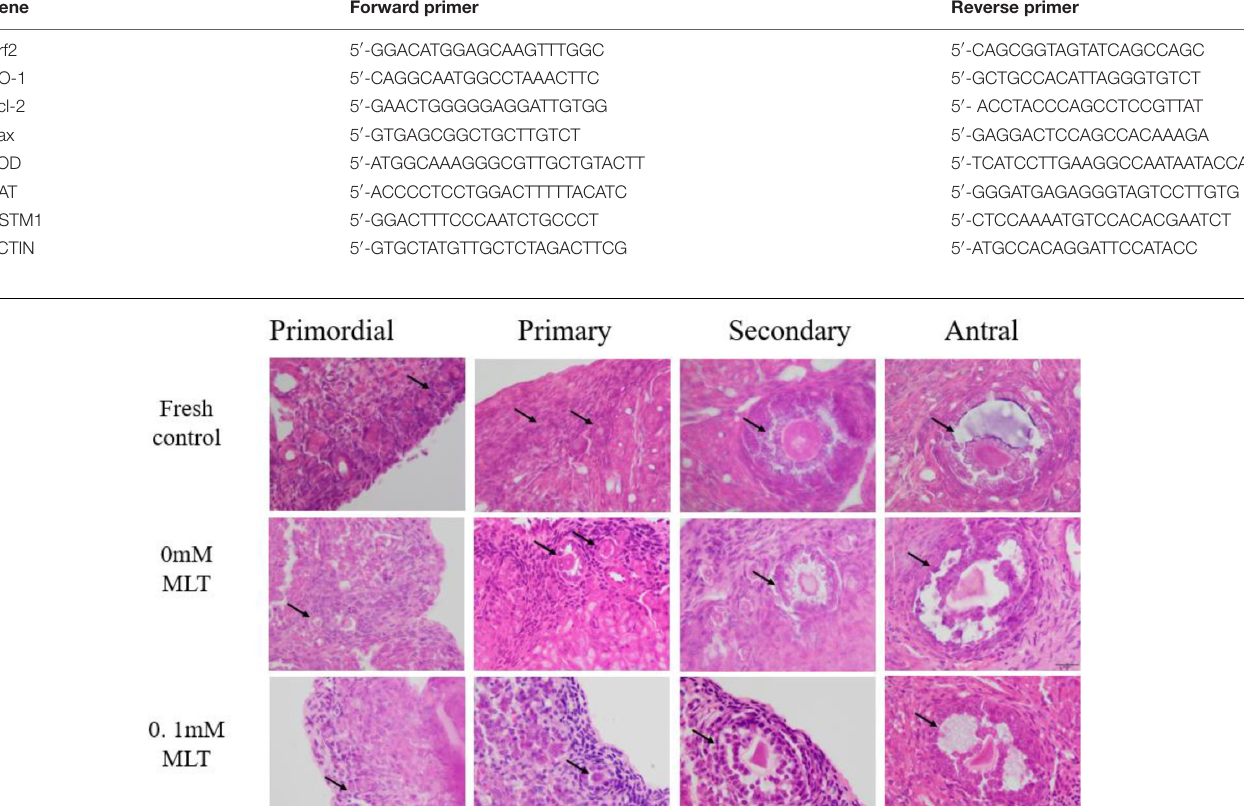
Frontiers in Molecular Biosciences |